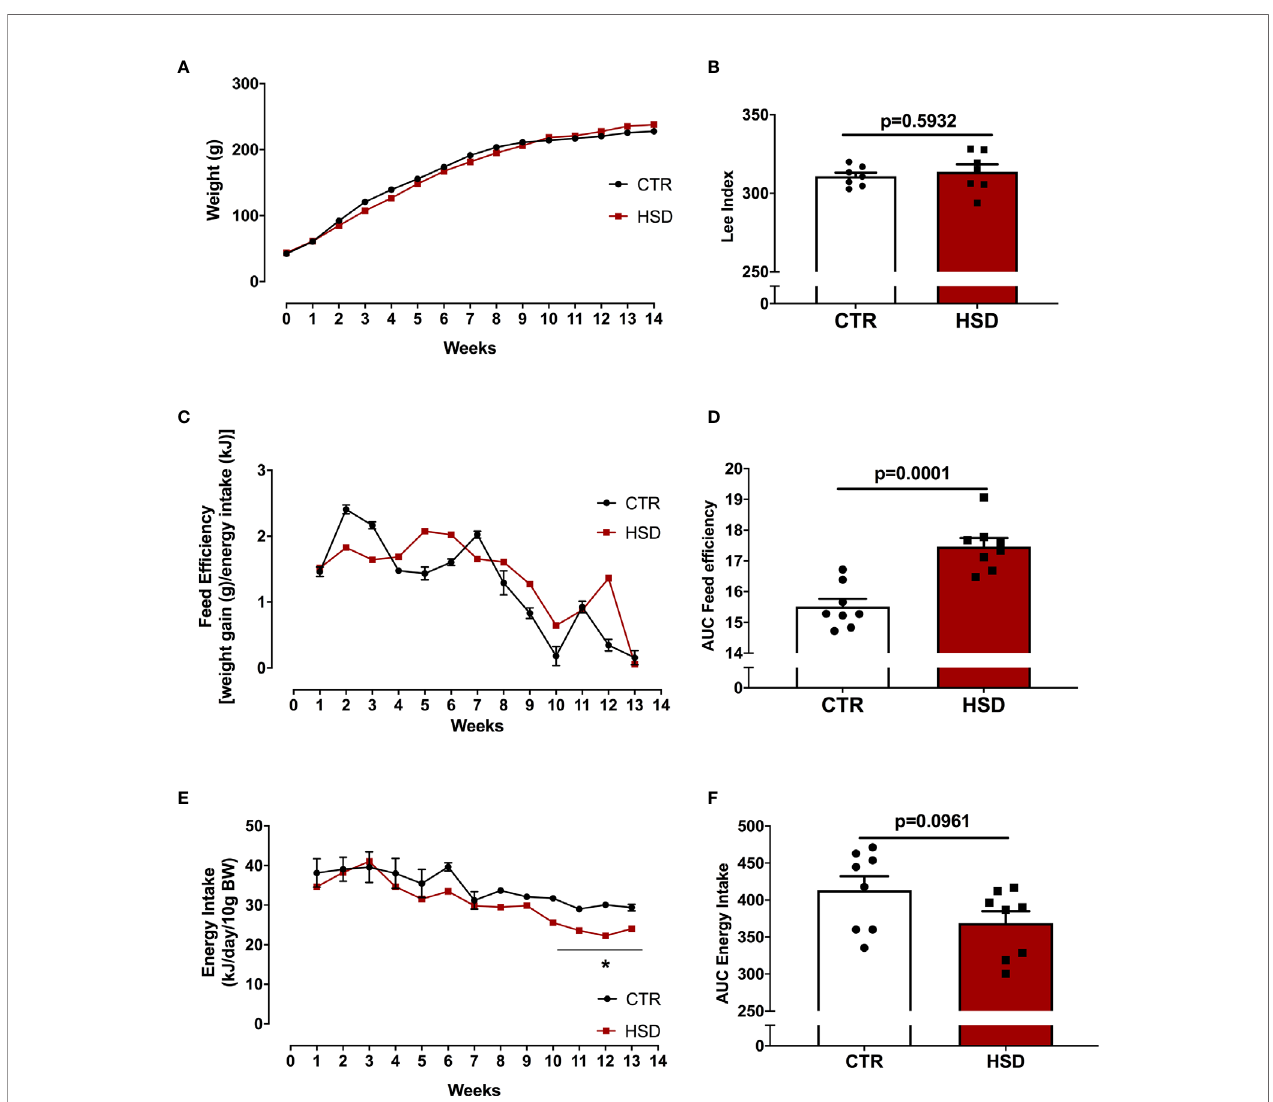
FIGURE 1 | HSD ingestion results in no weight gain in spite of higher feed ef fi ciency. (A) All animals were weighed weekly from pnd 21 (week 0) until pnd 120 (week 14). (B) Lee Index was calculated as described in Materials and Methods. (C) Feed ef fi ciency was also monitored throughout dietary intervention. (D) Area under the curve (AUC) of feed ef fi ciency. (E) Energy intake calculated as described in Materials and Methods . (F) AUC of energy intake. n=8 animals in each group. Graphs express mean ± SEM and bar graphs show individual values. *p < 0.05 vs CTR, assessed by two-way ANOVA with Tukey ’ s post-test. P-value presented for bar graphs and calculated through unpaired Student